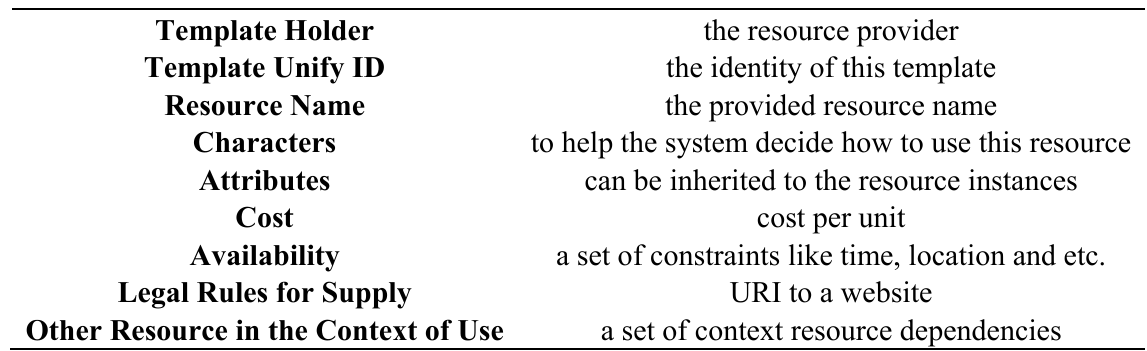
Table 1. Resource Supply Description Template